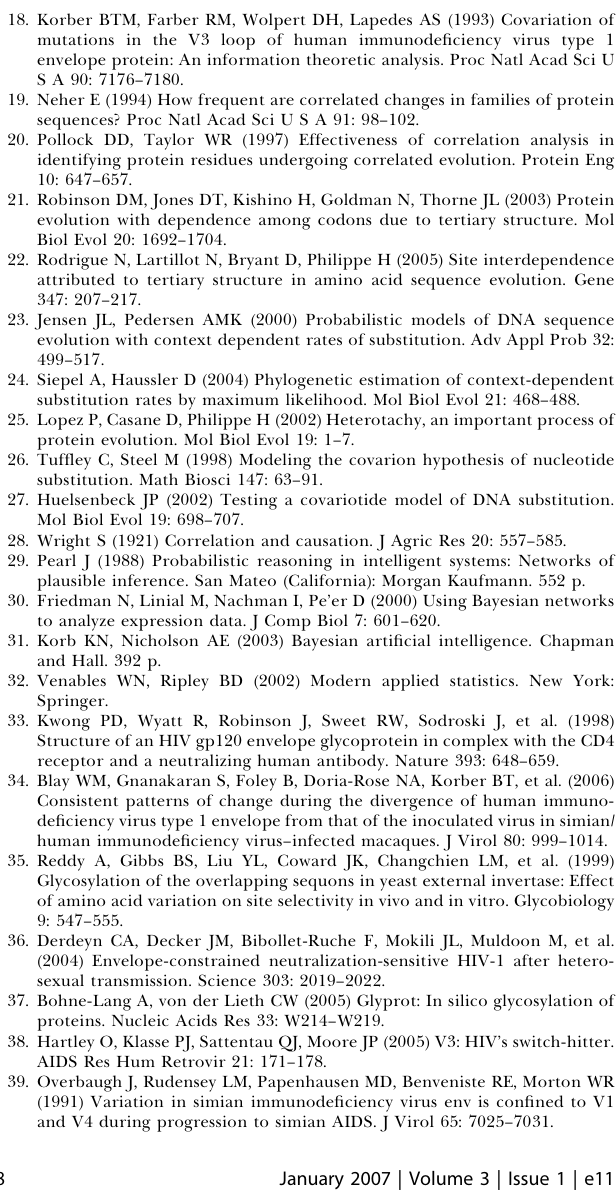
Figure S2. Bootstrap Tree of HIV-1 Envelope Sequences Internal branches are colored red to indicate . 70% bootstrap support, green to indicate 50%–70% bootstrap support, and black otherwise. Bootstrap support values were estimated from 100 replicate samples. Branch lengths are derived from the neighbor- joining tree [45] based on the Tamura-Nei [46] distance measure, applied to the nucleotide alignment excluding positions at which PNGSs are defined.